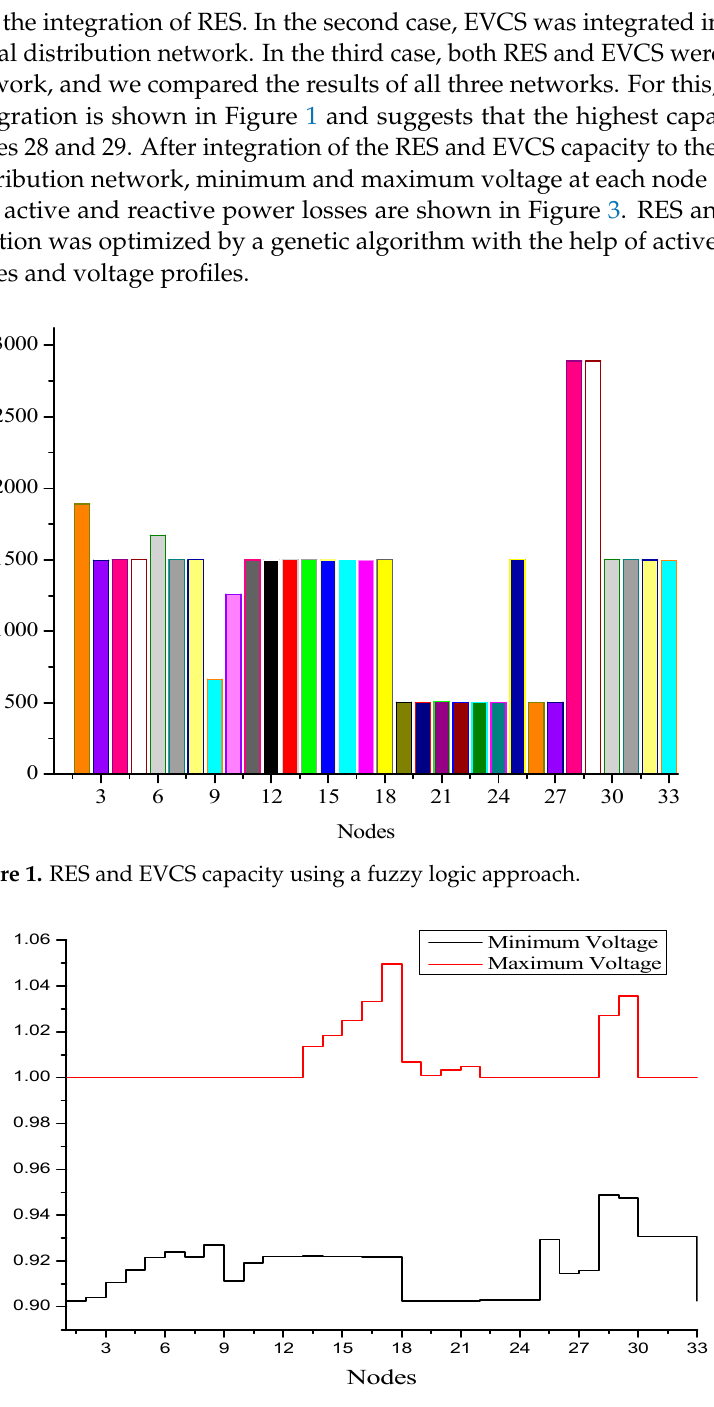
Figure 3. Active and reactive power losses at each node after integration of RES and EVCS. 6.2. RES Integration RESs are integrated using a genetic algorithm where active and reactive power losses are minimum and voltage profile is in constraints defined by (24) and (25). RESs are integrated at node 28 using a genetic algorithm with a capacity of 2891.56 kVA and, after integration of RES, active power losses are reduced to 185.35 kW from 216.84 kW, as shown in Figure 4. Reactive power losses are reduced to 139.1 kVAr from 141.34 kVAr, as shown in Figure 5. The minimum voltage profile is improved to 0.948 Per Unit (pu) and the maximum voltage profile is 1.027 pu within the constraints. According to the rules defined in the genetic algorithm, RES is integrated where active and reactive power losses are minimum. After integrating the optimized capacity of RES from fuzzy logic to the test system, minimum losses are obtained at node 30 but the voltage index at node 30 is noted in the defined range. After node 30, minimum losses are at node 28, and voltage index in the defined range is selected for integration of RES. The voltage profile after integration of RES at node 28 is shown in Figure 6.